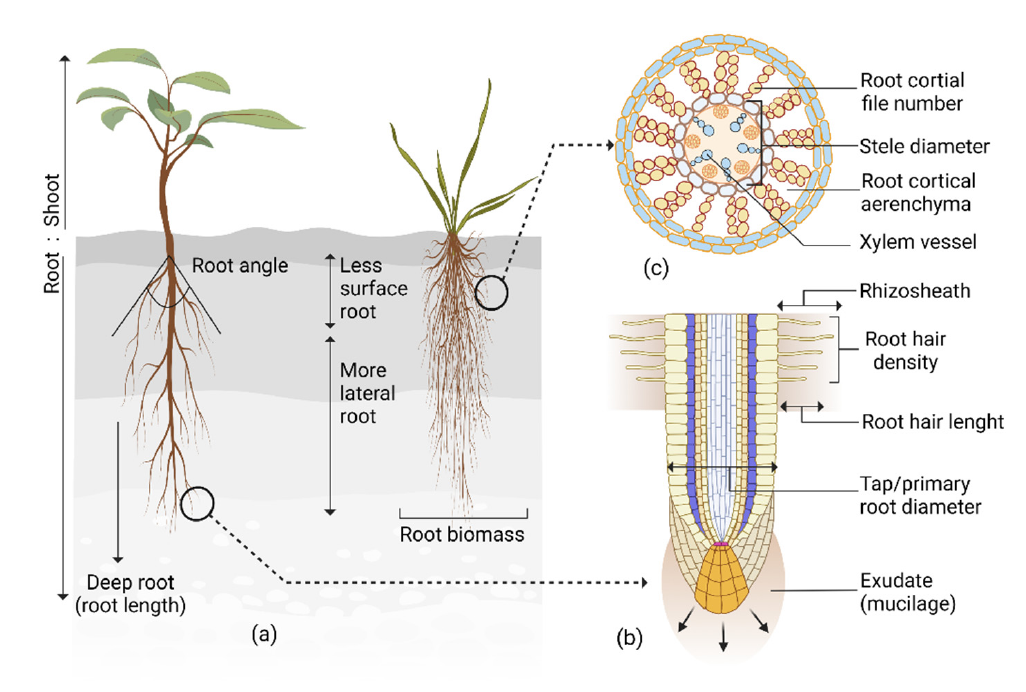
Figure 1. Drought adaptive root traits. ( a ) Changes in root angle, length, and biomass; the ratio with the shoot, and increased lateral branching facilitate plant adaptation to drought; ( b ) Root hair length and density, rhizosheath size, taproot diameter, and exudates are crucial drought-responsive traits. ( c ) Plants adapt their anatomical traits such as root cortical file number, cortical aerenchyma, stele diameter, and xylem vessel in response to drought.